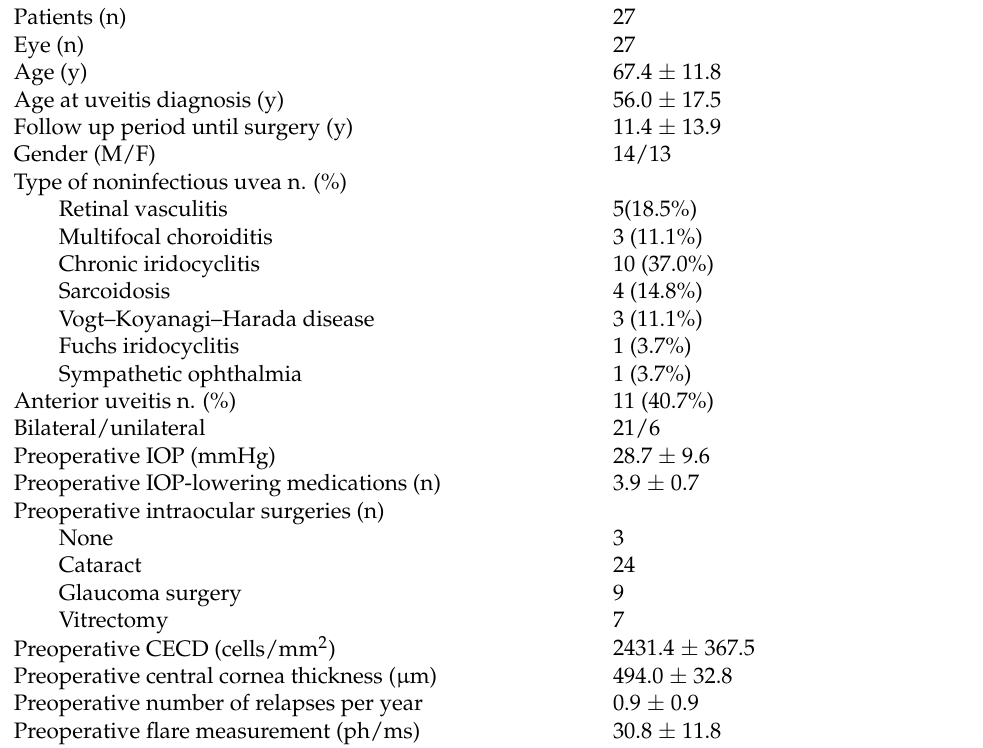
Table 1. Patients’ baseline characteristics.